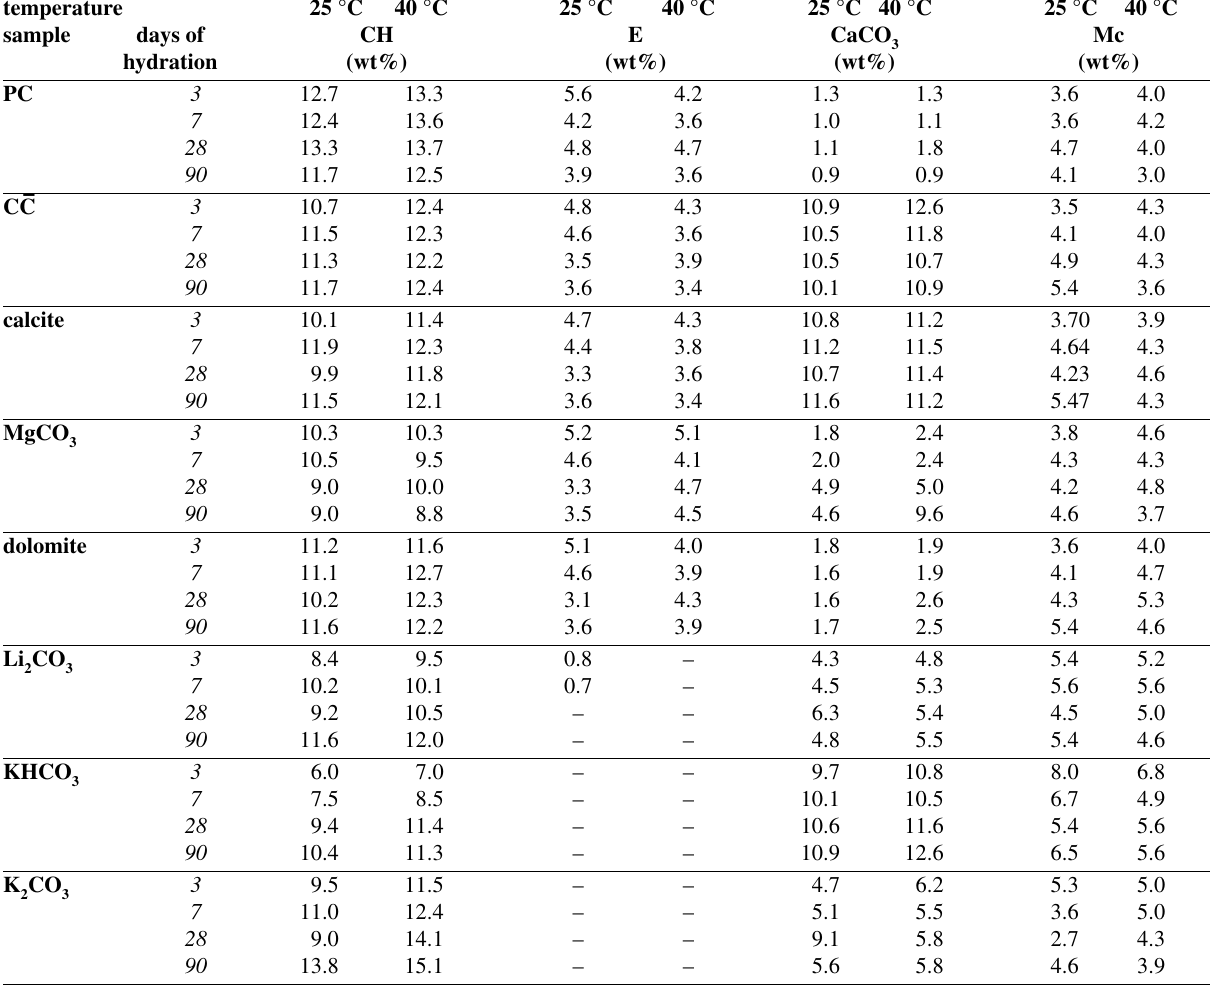
Table 3. The average compositions of hydration products in relation to hydration time and temperature. temperature